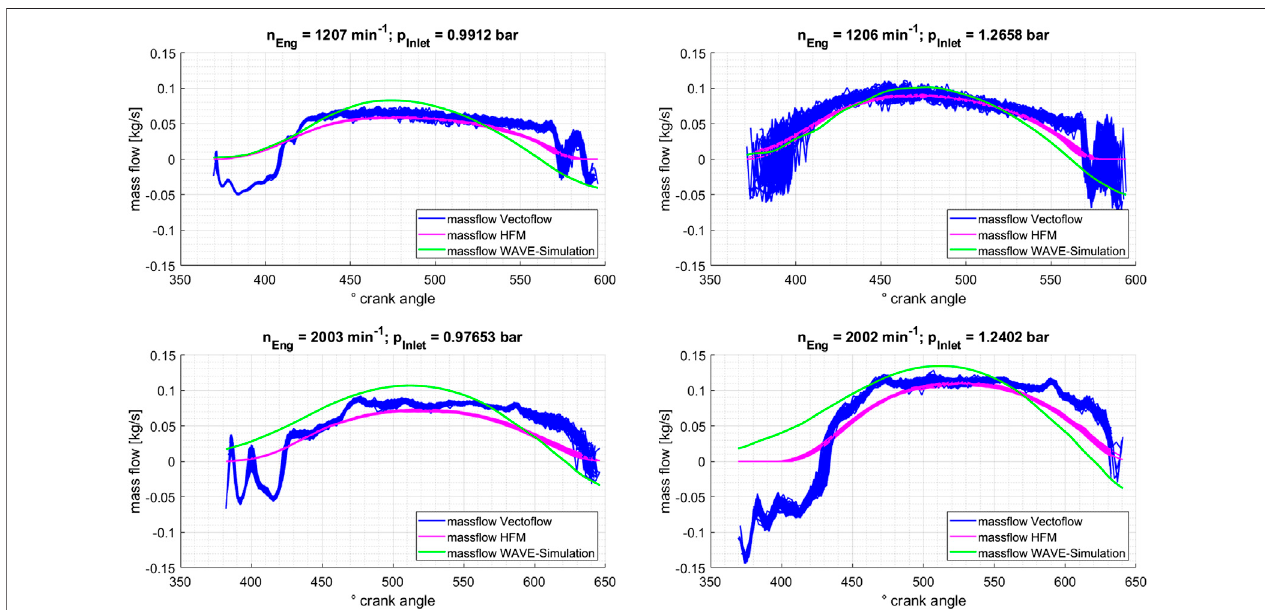
FIGURE 7 | Individual cycle dynamic pressure in the inlet duct of 50 consecutive cycles at an engine speed of 1,200 rpm.